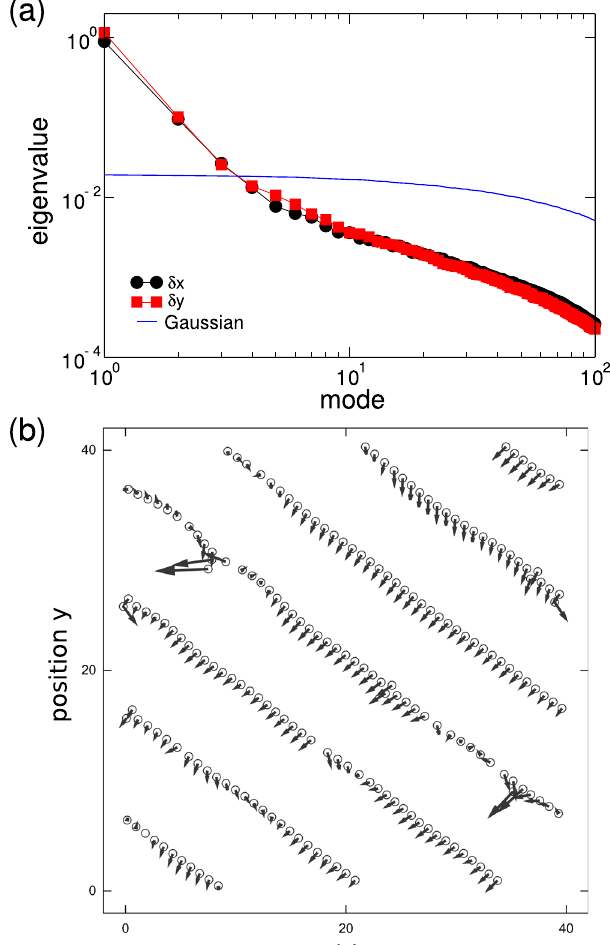
Figure 5. Growth of correlated motion. ( a ) Spectrum of eigenvalues of the displacement covariance matrix (for a system with φ = 0.1 ( N = 200, L = 40 σ ) and λ = 8 σ ) and comparison with a model of Gaussian-distributed random displacements. The largest eigenvalue mode corresponds to a Goldstone mode propagating through the system. ( b ) We show the collective fluctuation in the agents’ positions due to a Goldstone mode propagating through the system when elongated linear chain patterns emerge. As complex patterns emerge and Galilean invariance is spontaneously broken, collective fluctuations materialize through the propagation of a Goldstone